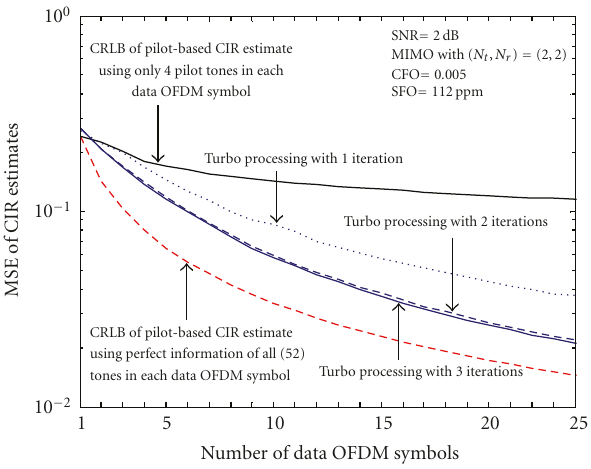
Figure 4: MSE and CRLB of CIR estimates. Figure 5: MSE and CRLB of CFO estimates.